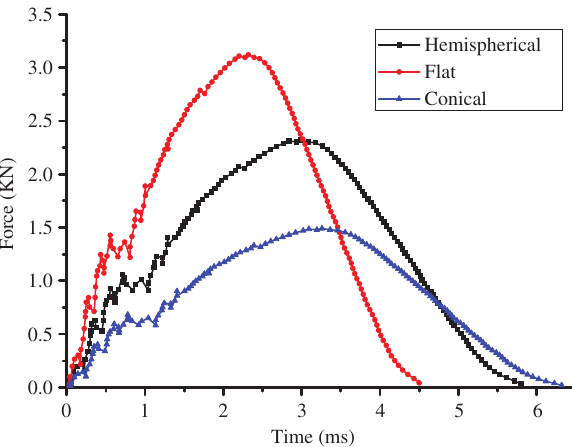
Figure 19: The time curve on the impact contact force with different impactor geometric shapes.